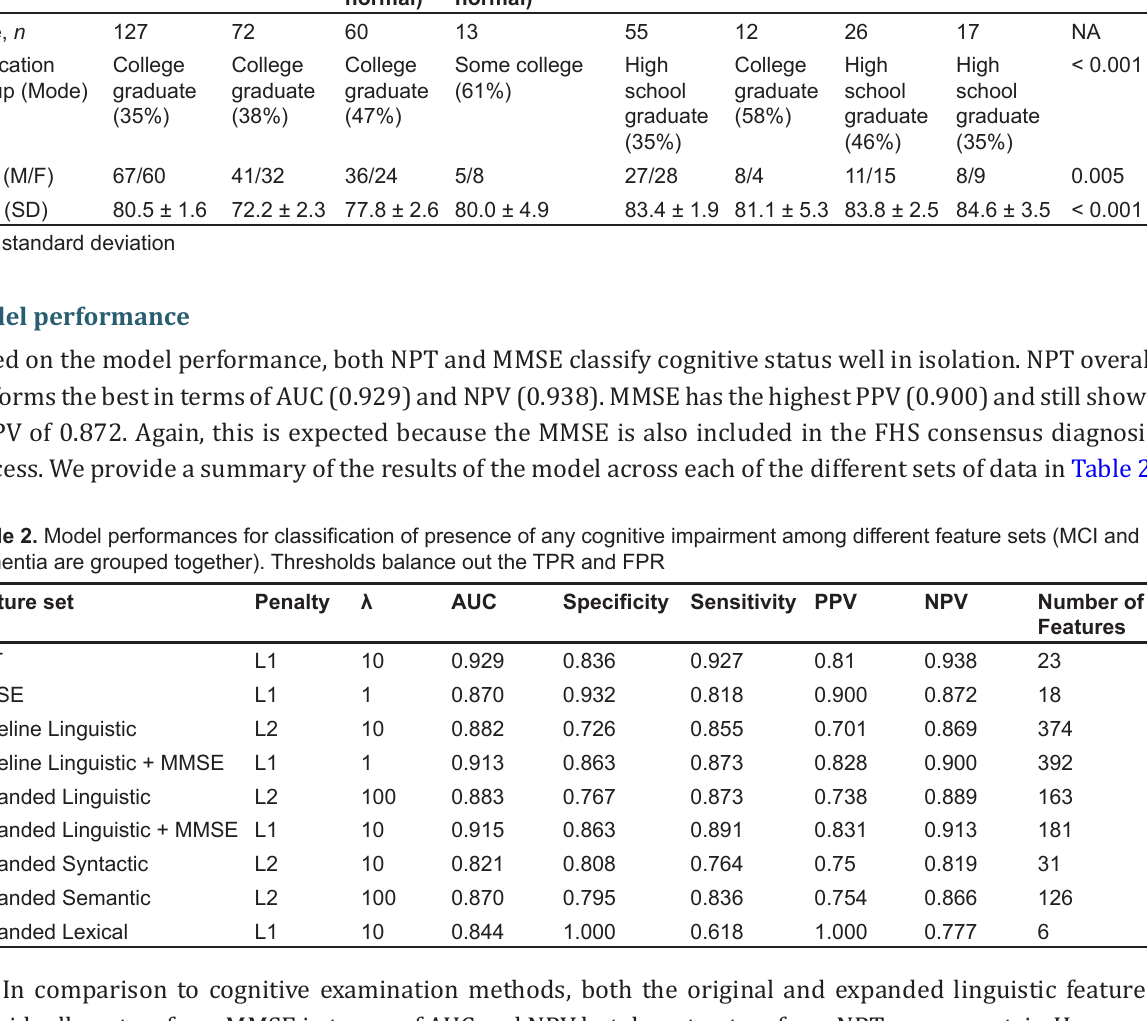
Moderate dementia dementia